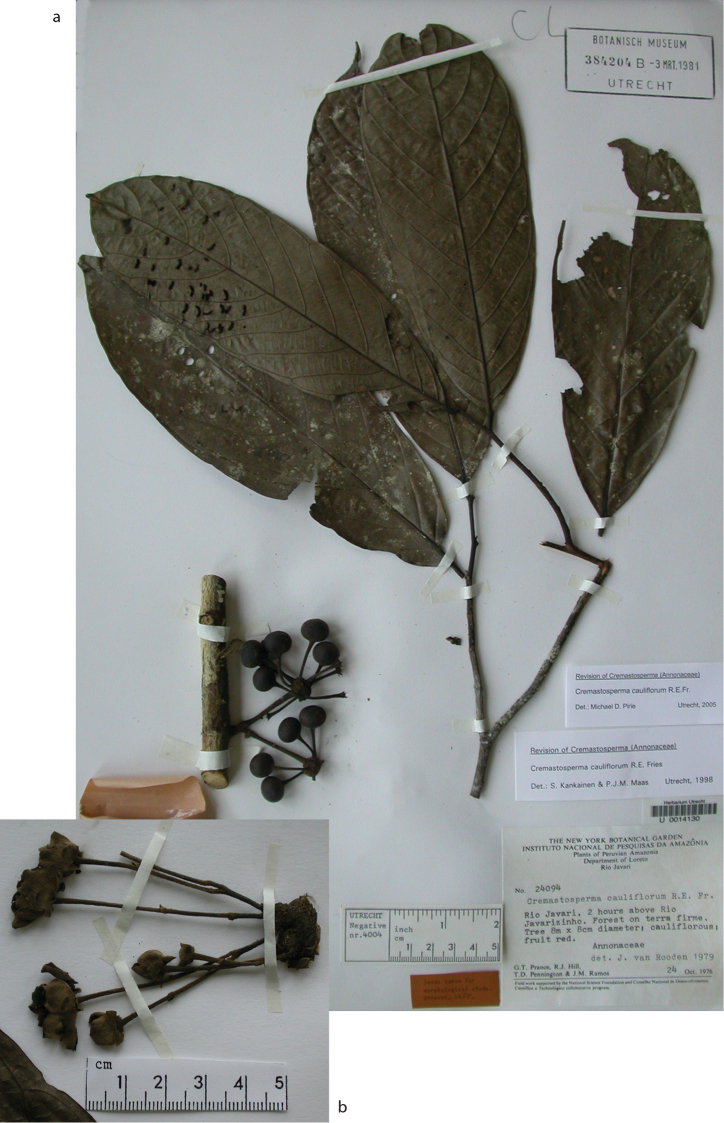
Cremastospermacauliflorum R.E.Fr. a fruiting specimen b inflorescence (aPrance et al. 24094bVasquez & N. Jaramillo 11423).